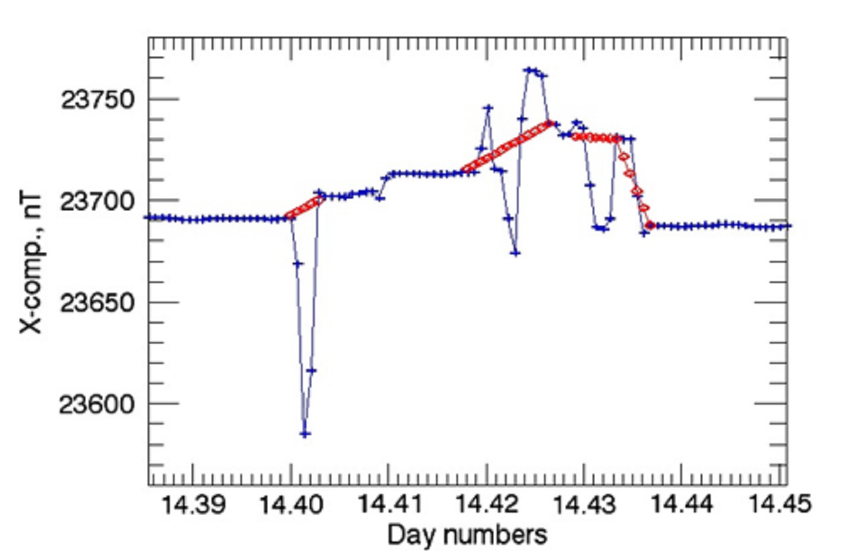
Fig.3. The figure demonstrates how the peak removal is working. The original data are shown by plusses connected by a line. The interpolated data are drawn by diamonds, connected also by a line. In the left side near the day number of 14.40 (22.02.2017) a single peak, detected and removed, is presented. In the right side a sequence of peaks was found and removed by linear interpolation. The sequence of days is the same as in